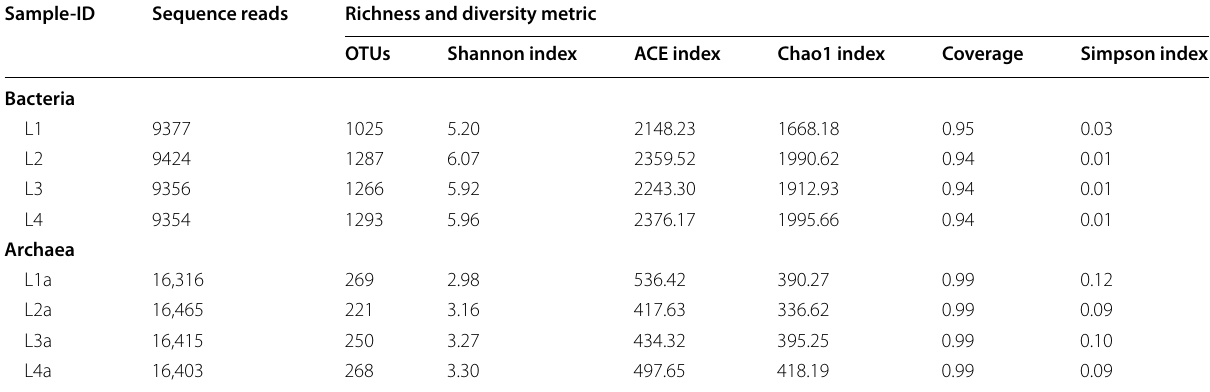
ACE abundance-based coverage